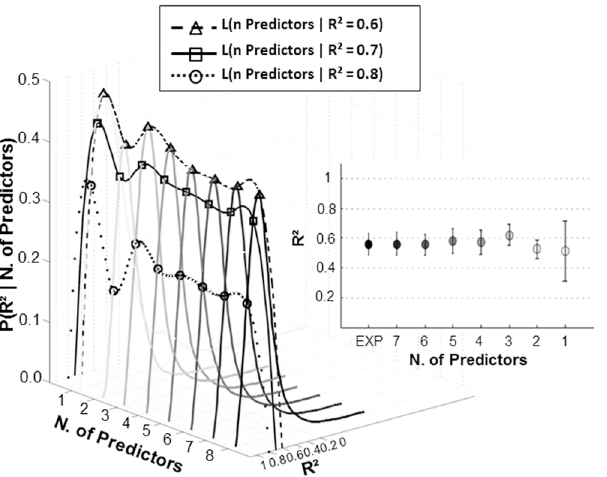
Fig 7. Probability density function of R 2 values per each nested model. Each curve illustrates the distribution of R 2 measures given each nested model ’ s number of predictors. R 2 values quantify to what extent the muscle-metric curve, obtained from each nested model output, is able to account for psychophysical decisions. Triangles, squares and circles as well as dashed, continuous and dotted lines indicate the probability (i.e., Likelihood) of each model to provide predictions about the psychophysical decision with a coefficient of determination of 0.6, 0.7 and 0.8, respectively. R² distributions were obtained by merging together the simulation outcomes of the same 9 subjects considered in Fig 4. Inset graph depicts across subjects median and SE of R 2 values from bootstrap resampling, obtained by calculating the explained variance of the muscle-metric curve in accounting for the probability of upward force detection. The model with 8 predictors (i.e., EXP ) represents the empirical data.